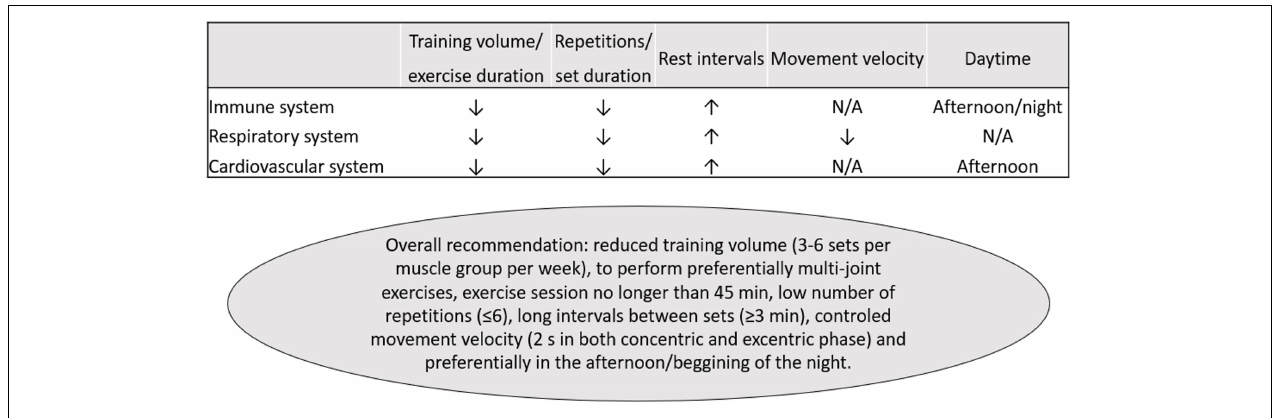
FIGURE 2 | Practical recommendations for resistance training in COVID-19 survivors. ↑ , higher; ↓ , lower. N/A, not available.